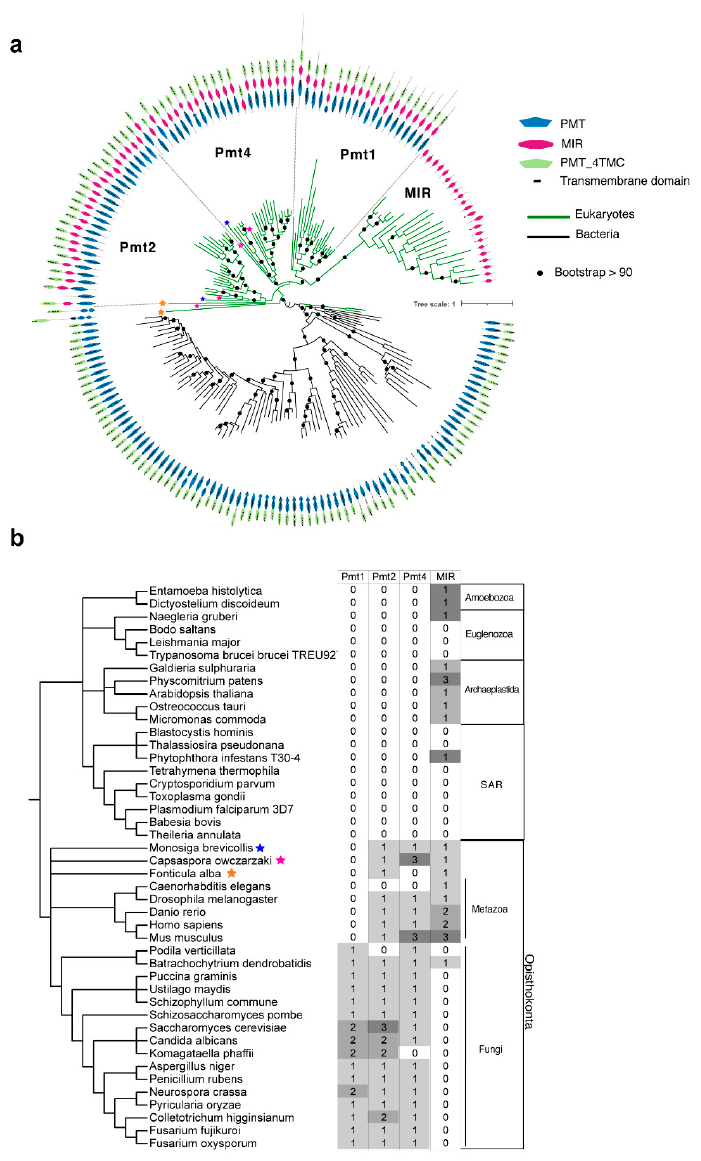
Figure 2. Evolutionary analyses of Pmt proteins. ( a ) Phylogeny and domain architecture of the closest homologs to Pmt proteins. This phylogeny represents the general features of the closest homologs to Pmt and is not for inferring the order of appearance of these protein families. Stars indicate early-branching opisthokonts. The tree was artificially rooted at the split of Pmt with and without MIR domains. An extended version of this reconstruction is provided in Figure S1. ( b ) Distribution of different Pmt proteins was identified in the phylogenetic reconstructions. The taxonomic tree was obtained from NCBI taxonomy tools (https://www.ncbi.nlm.nih.gov/taxonomy, accessed on 21 April 2021).